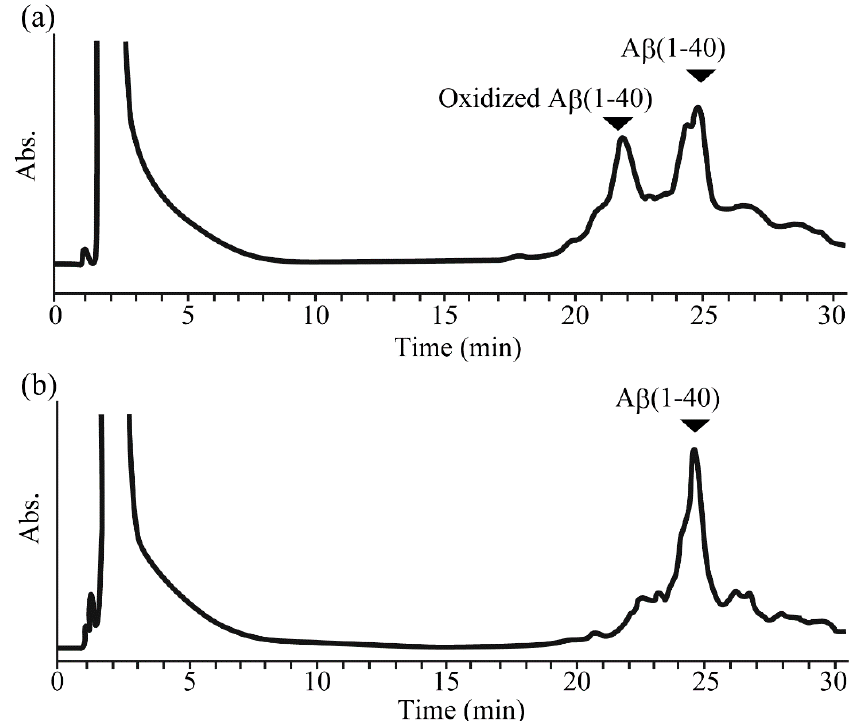
Figure 2. ( a ) HPLC chart of the cleaved A β (1-40) from HMBA resin without the reduction process. ( b ) HPLC chart of the cleaved A β (1-40) from HMBA resin with the reduction process. The peaks were characterized by MALDI-TOF MS: the oxidized A β (1-40), m / z 4346.9 ((M + H) + calcd. 4346.6); A β (1-40), m / z 4330.8 ((M + H) + calcd. 4330.6).